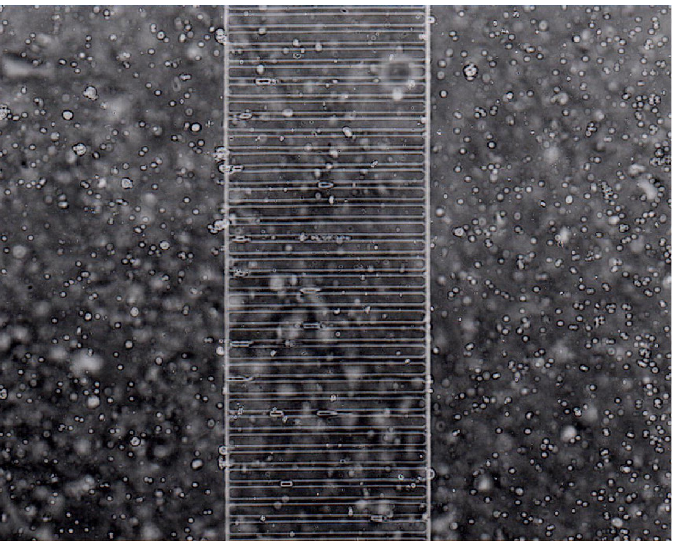
Figure 1. Microfluidic chip environment: two chambers connected by multiple channels. Credits by Vacchelli et al [47] edited by AAAS.